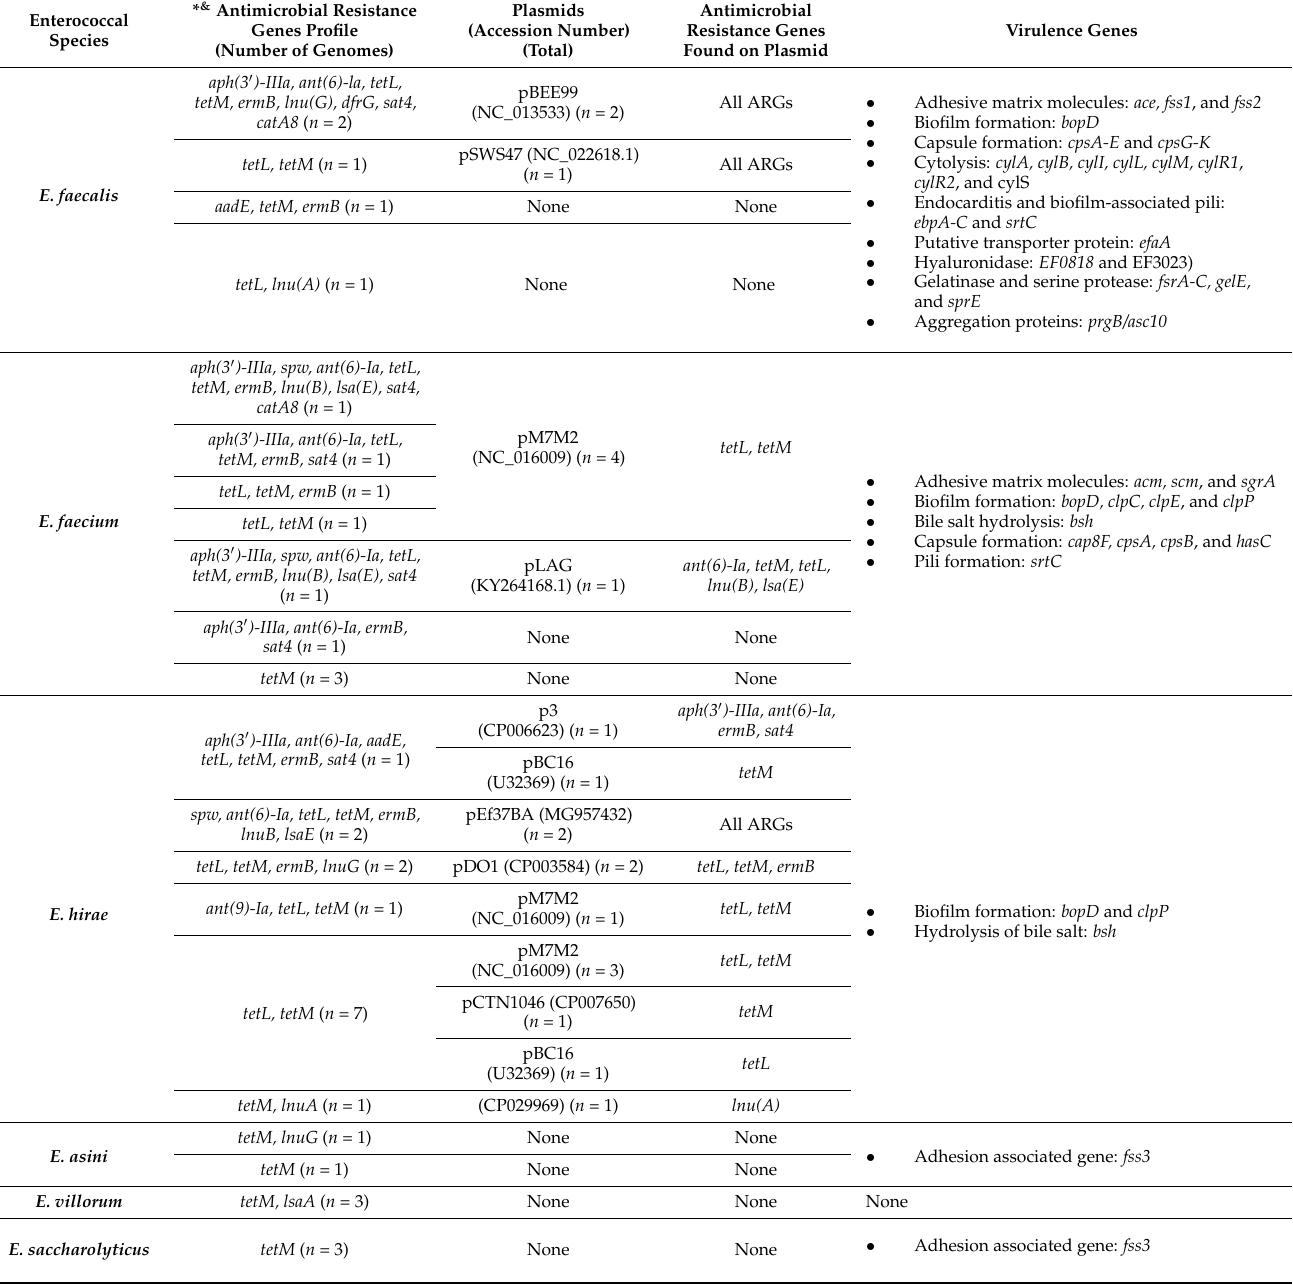
Table 2. Antimicrobial resistance genes profiles, plasmids harboring AMR genes, and virulence genes identified in enterococcal species recovered from swine